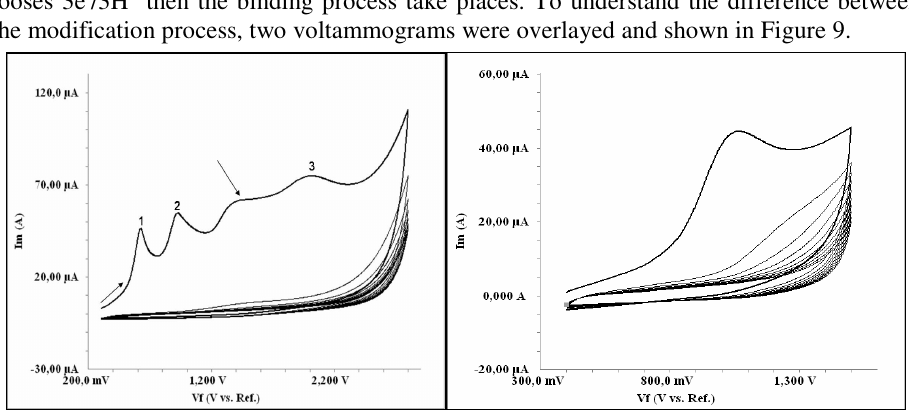
Figure 9. Cyclic voltammograms of quercetin on procaine and aminophenyl